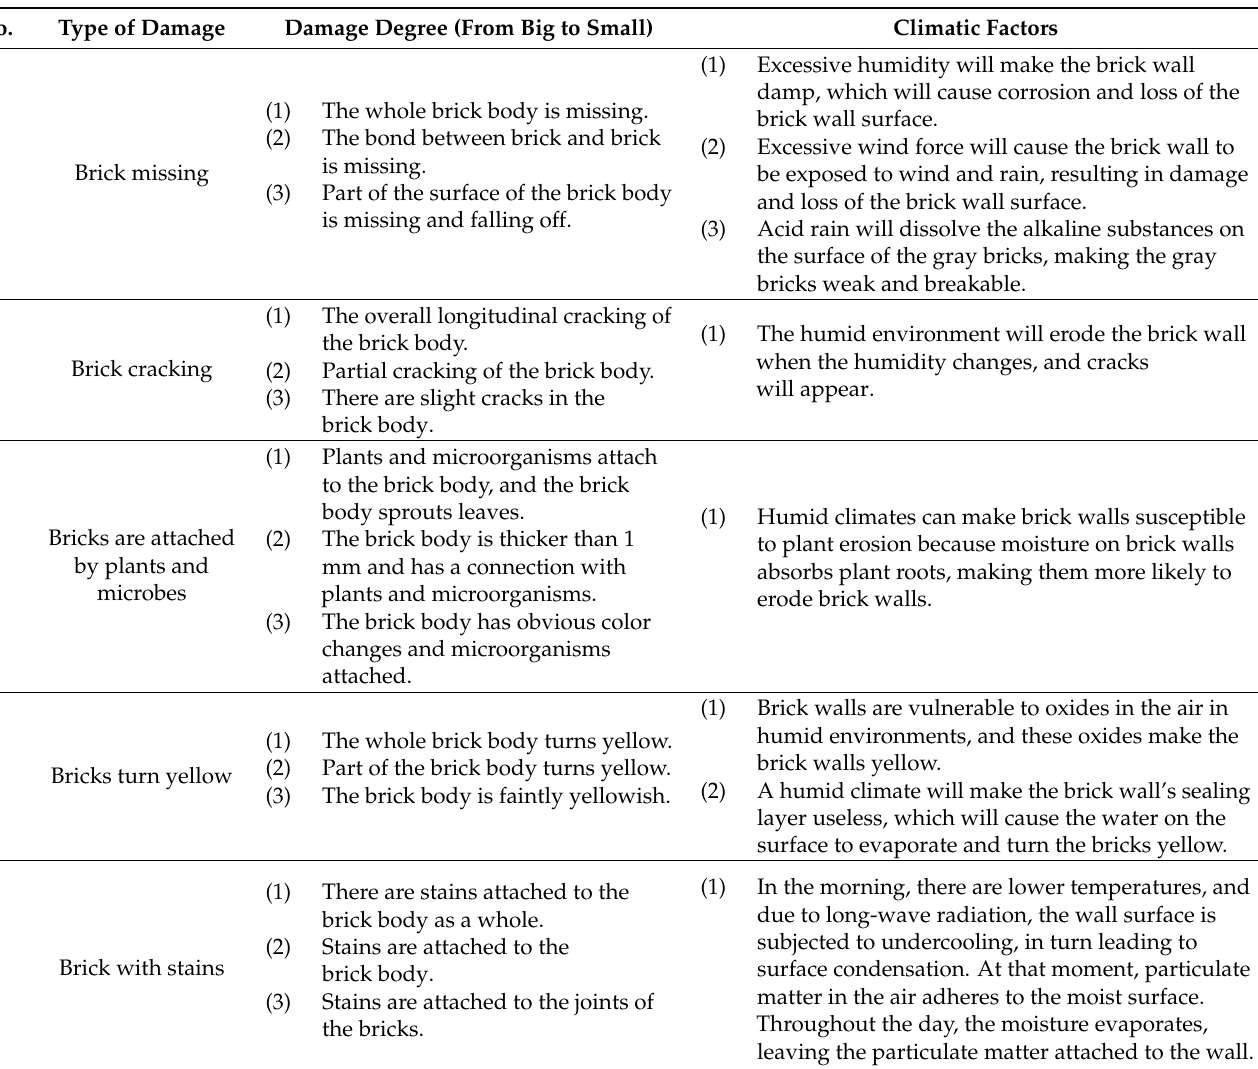
Table 1. The relationship between the types of damage to gray bricks and climate